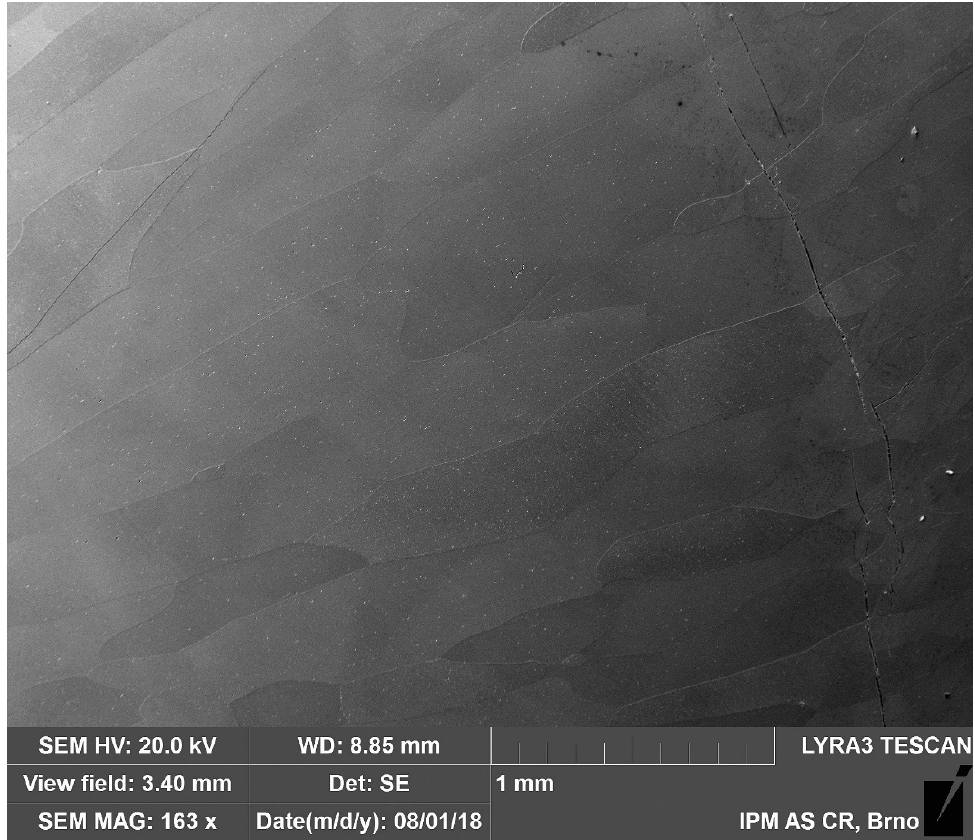
Figure 3. Backscattered electron micrograph of metallographic section of the uncrept alloy.